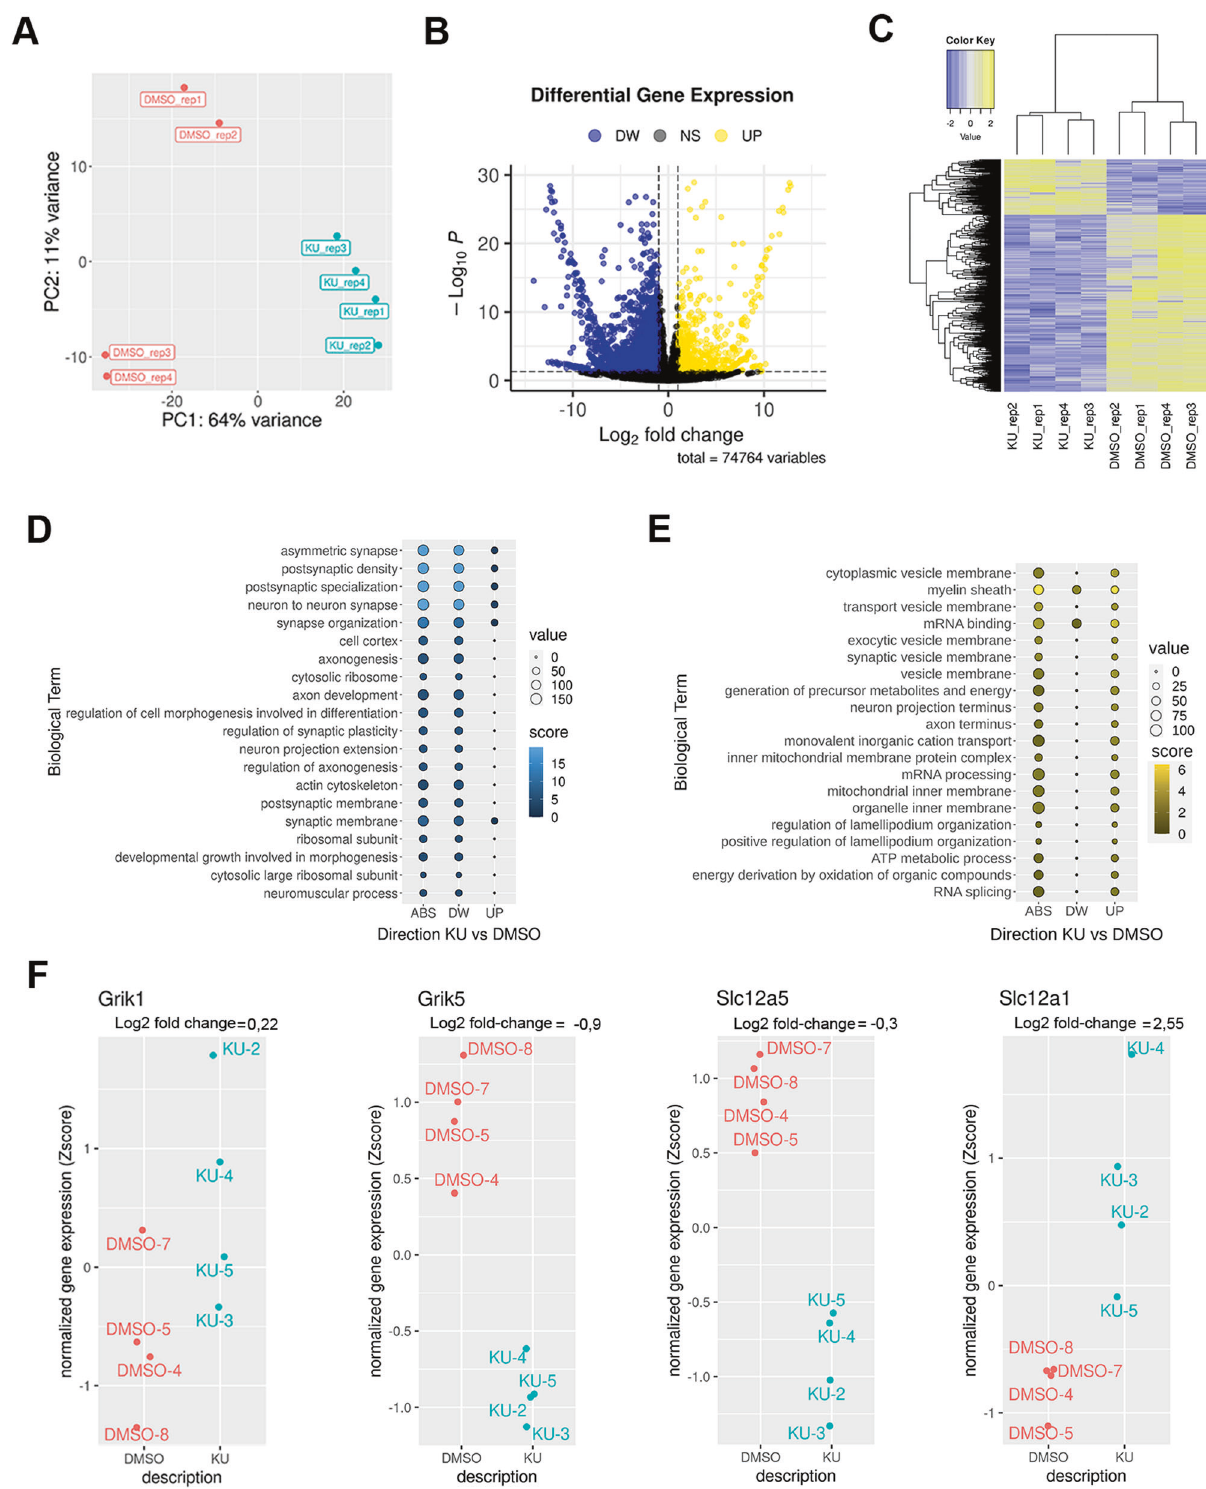
since SNAP-25 is also post-synaptic [34], we excluded in this analysis the SNAP-25 signal along MAP2-positive dendrites. Results in Fig. 5B con fi rmed the increased KARs signal at the presynaptic compartment. Finally, we took advantage of the Triton-insoluble fraction (TIF) that is enriched with postsynaptic proteins ([35],